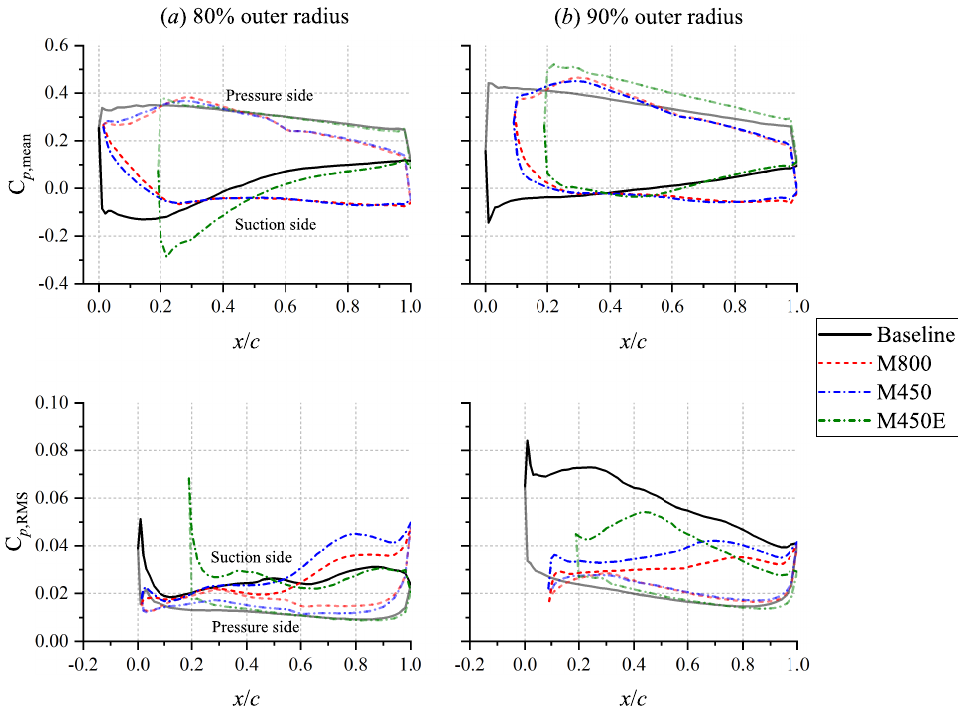
Figure 15. Plots of ( top row) time-averaged surface pressure coefficient and ( bottom row) RMS of surface pressure fluctuations at the outer span of the OGV. Pressure coefficient values shown are averaged over the 26 blades. The pressure distributions at the pressure side are plotted with lower opacity. For the M450E configuration, note that the LE porosity is only implemented at > 85% of the blade outer